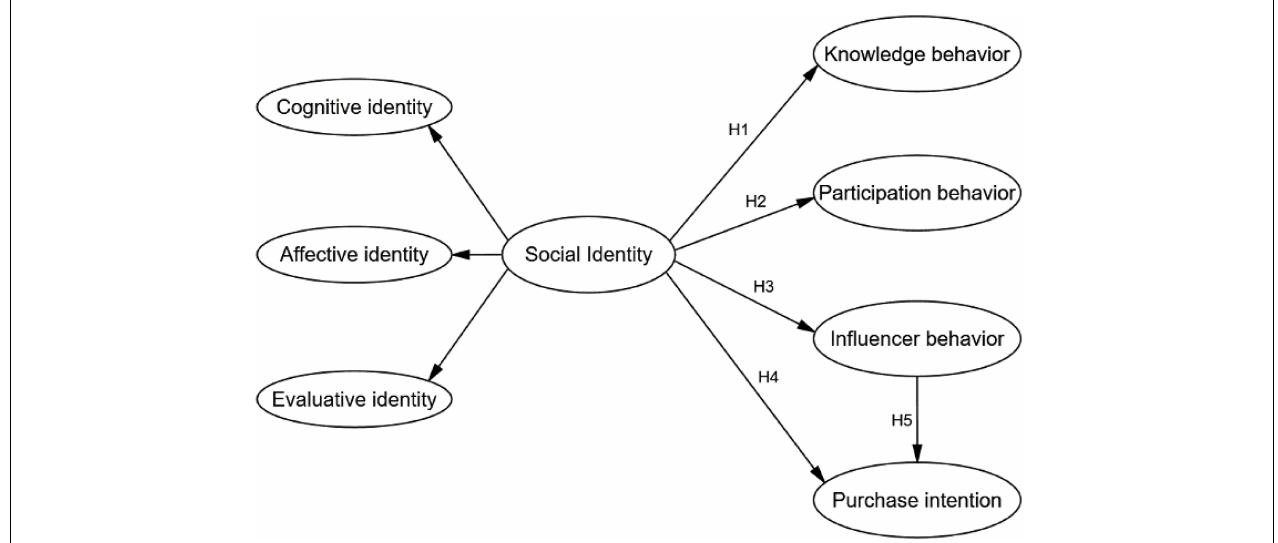
FIGURE 1 | The research